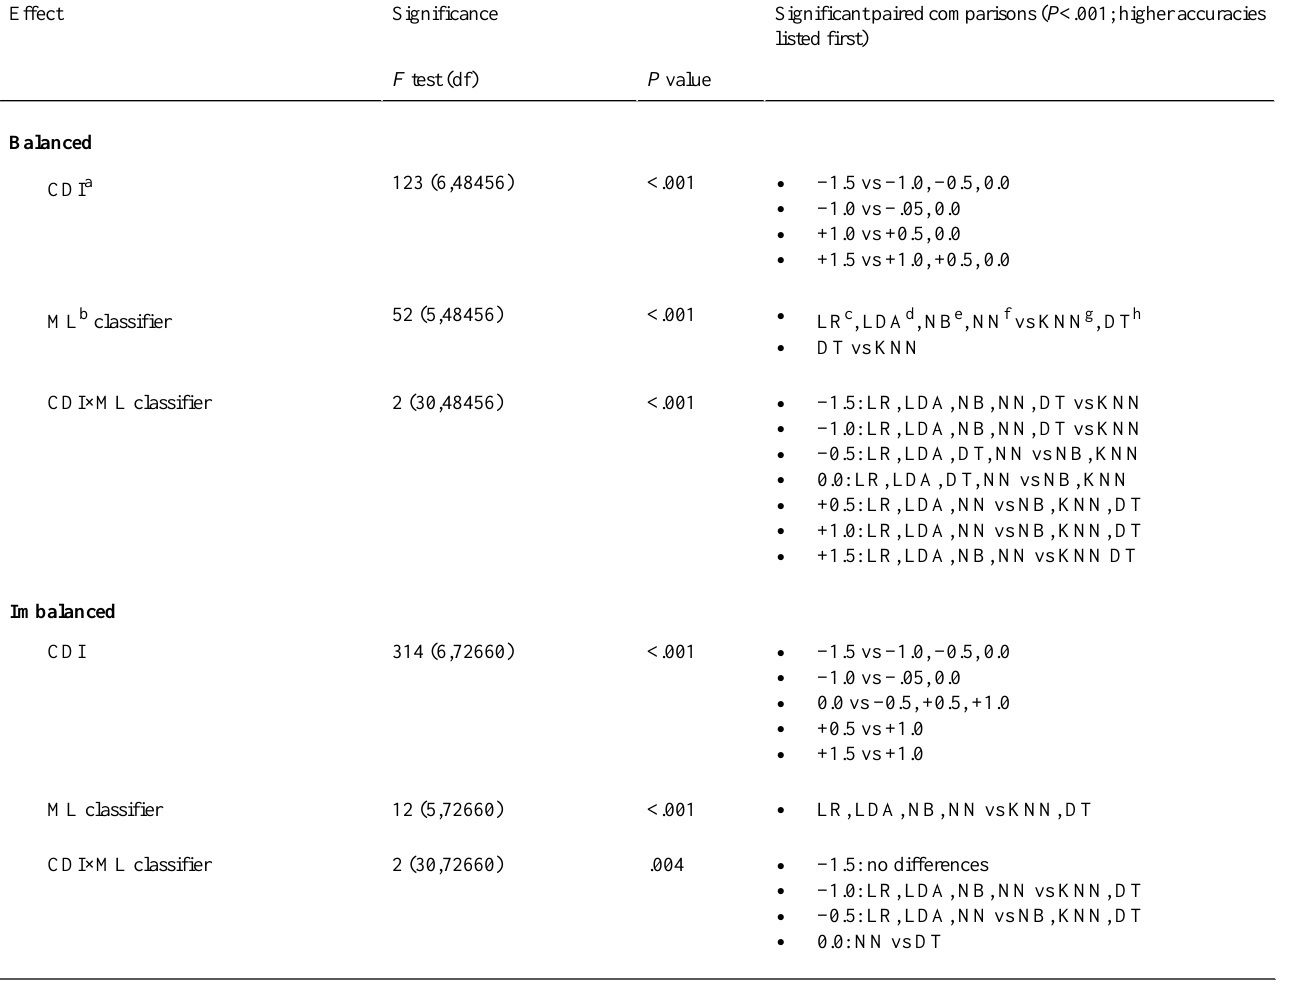
Table 10. Tests of the effects of classification difficulty index, classifier, and their interaction for the Medical Information Mart for Intensive Care III data